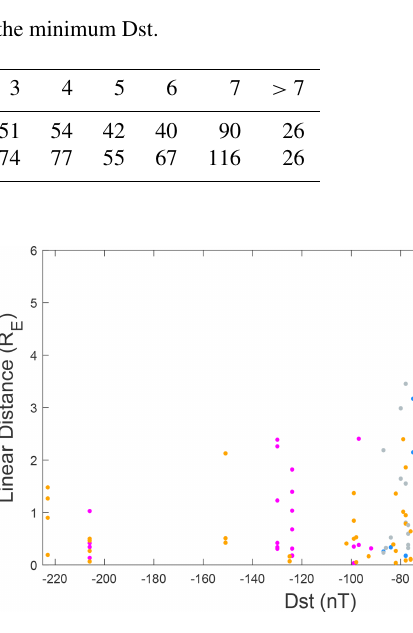
Figure 3. The category of observed events: the solid orange dots indicate plume events that are not in the recovery phase. The solid purple dots display the events with a corresponding Dst index less than − 70nT or greater than − 15nT. The solid blue and red dots represent the events with (cid:49)L less than 0.2 and Cartesian distances greater than 3.5 R E , respectively. The events in the Dst range of − 70 to − 15nT and − 90 to − 70nT eventually retained are indicated by black and gray dots,